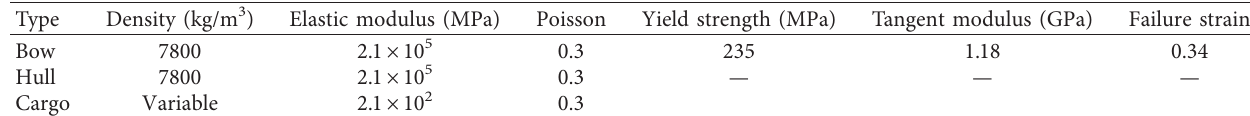
Figure 3: Finite element model of the barge-rigid wall Table 1: Material parameters of barge.